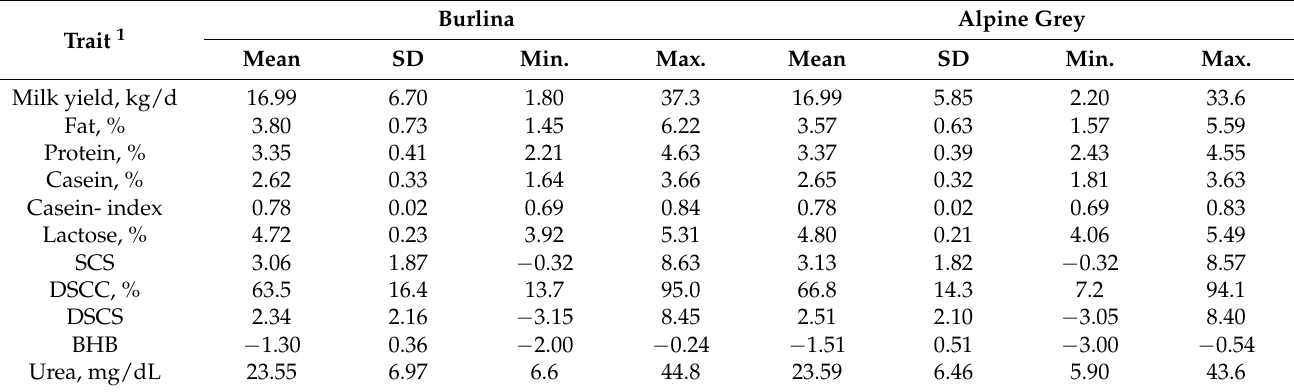
Table 1. Overview of descriptive statistics of milk test-day records for each